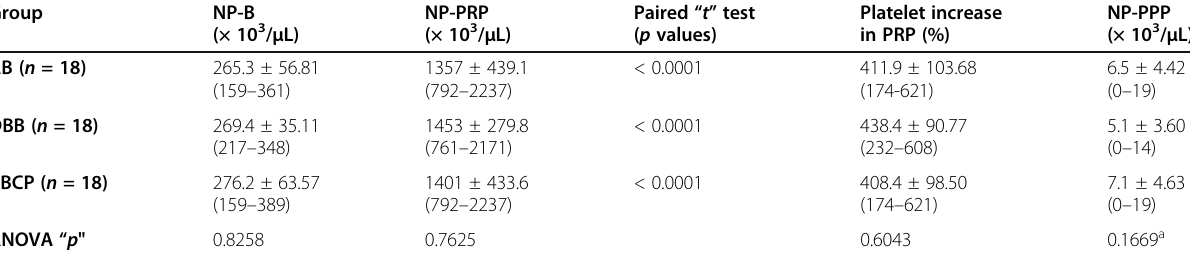
Table 1 Mean and ± SD (minimum and maximum) number of Platelets in whole blood (NP-B), PRP (NP-PRP), PPP (NP-PPP), and PRP platelet increase. One-way ANOVA Group NP-B (× 10 3 / μ L)